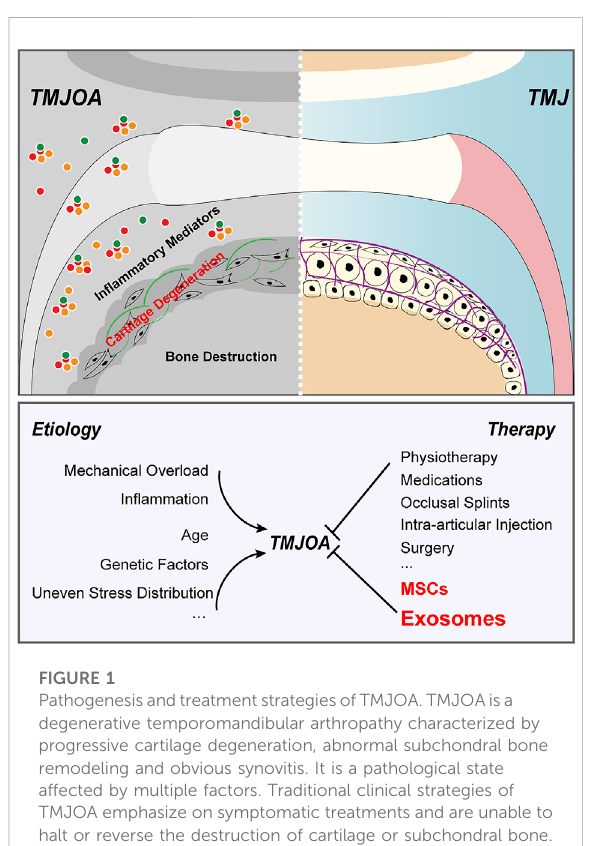
FIGURE 1 Pathogenesis andtreatmentstrategiesofTMJOA.TMJOAisa degenerative temporomandibular arthropathy characterized by progressive cartilage degeneration, abnormal subchondral bone remodeling and obvious synovitis. It is a pathological state affected by multiple factors. Traditional clinical strategies of TMJOA emphasize on symptomatic treatments and are unable to halt or reverse the destruction of cartilage or subchondral bone. MSCs and exosomes are highly promising for TMJOA